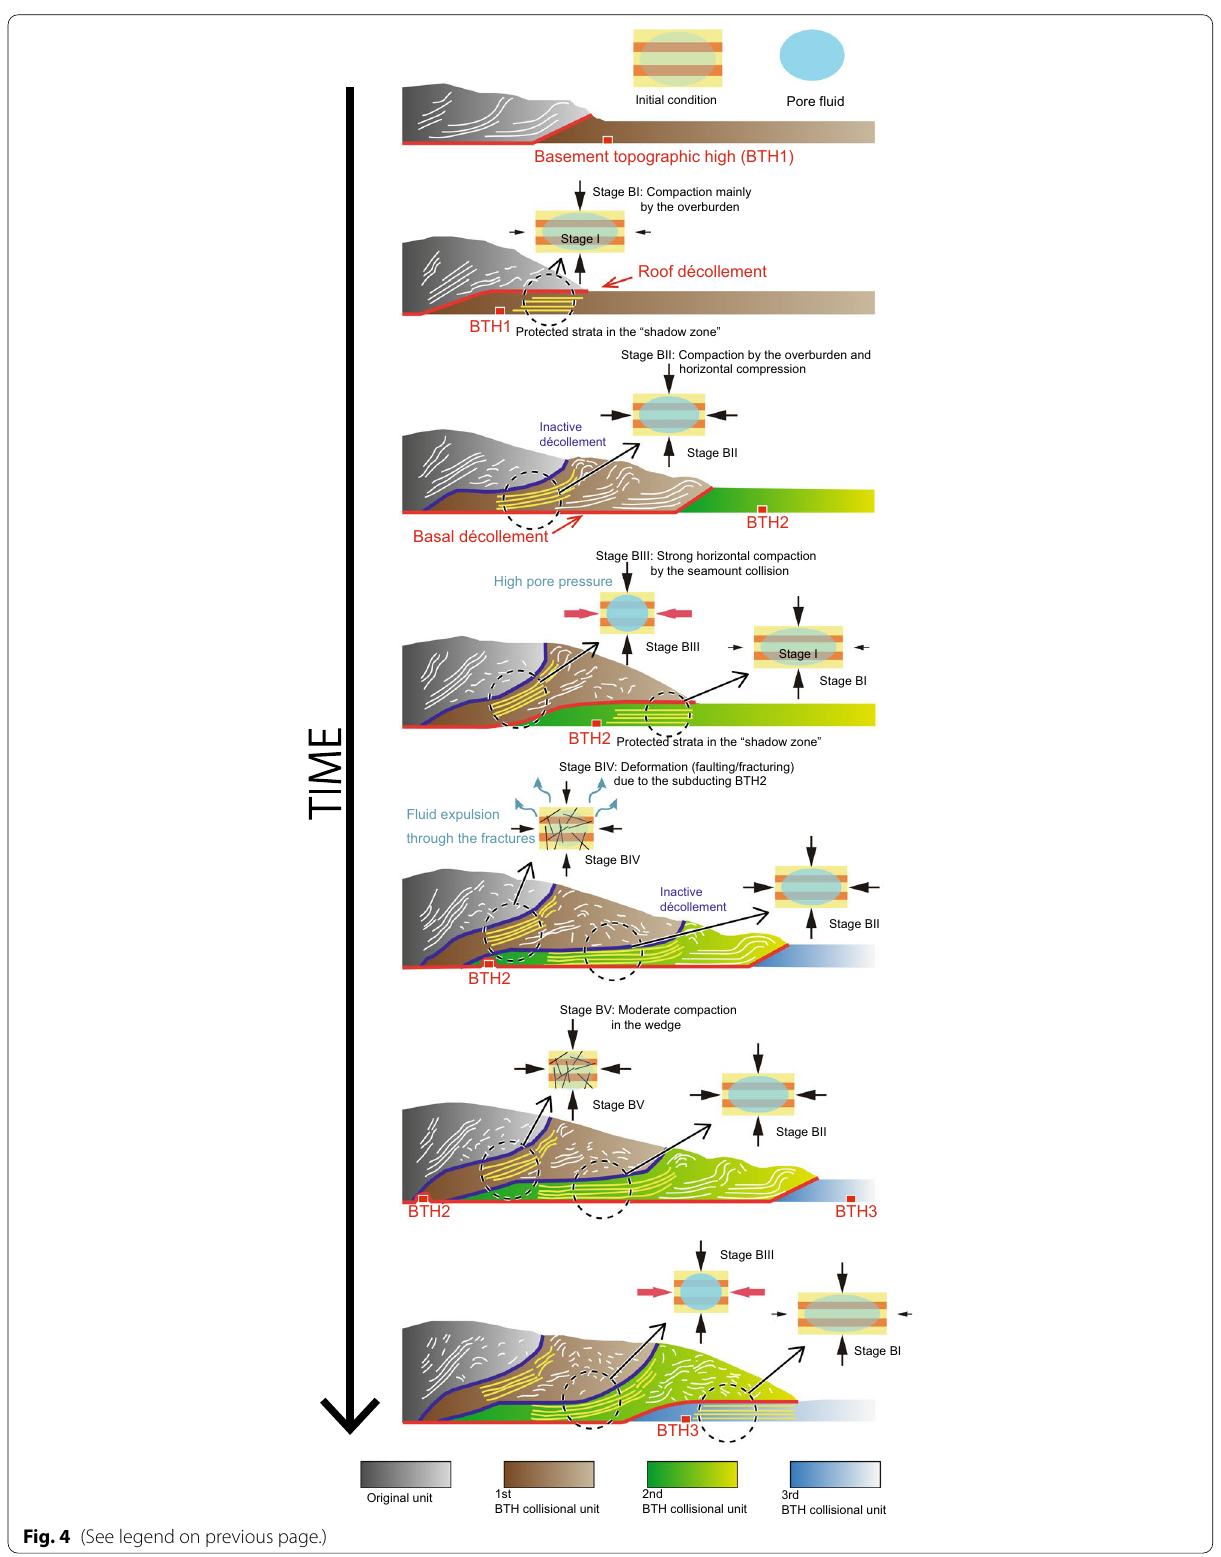
Fig. 4 (See legend on previous